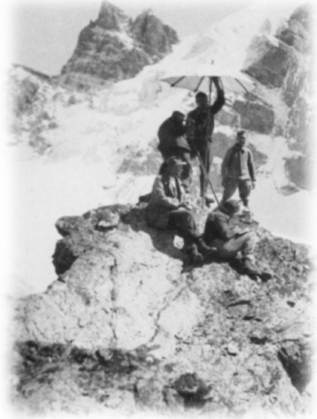
Figure 4. A terrestrial phototheodolite station in Switzerland, although post-1925, cadastral surveys were almost exclusively completed using aerial survey (adapted from